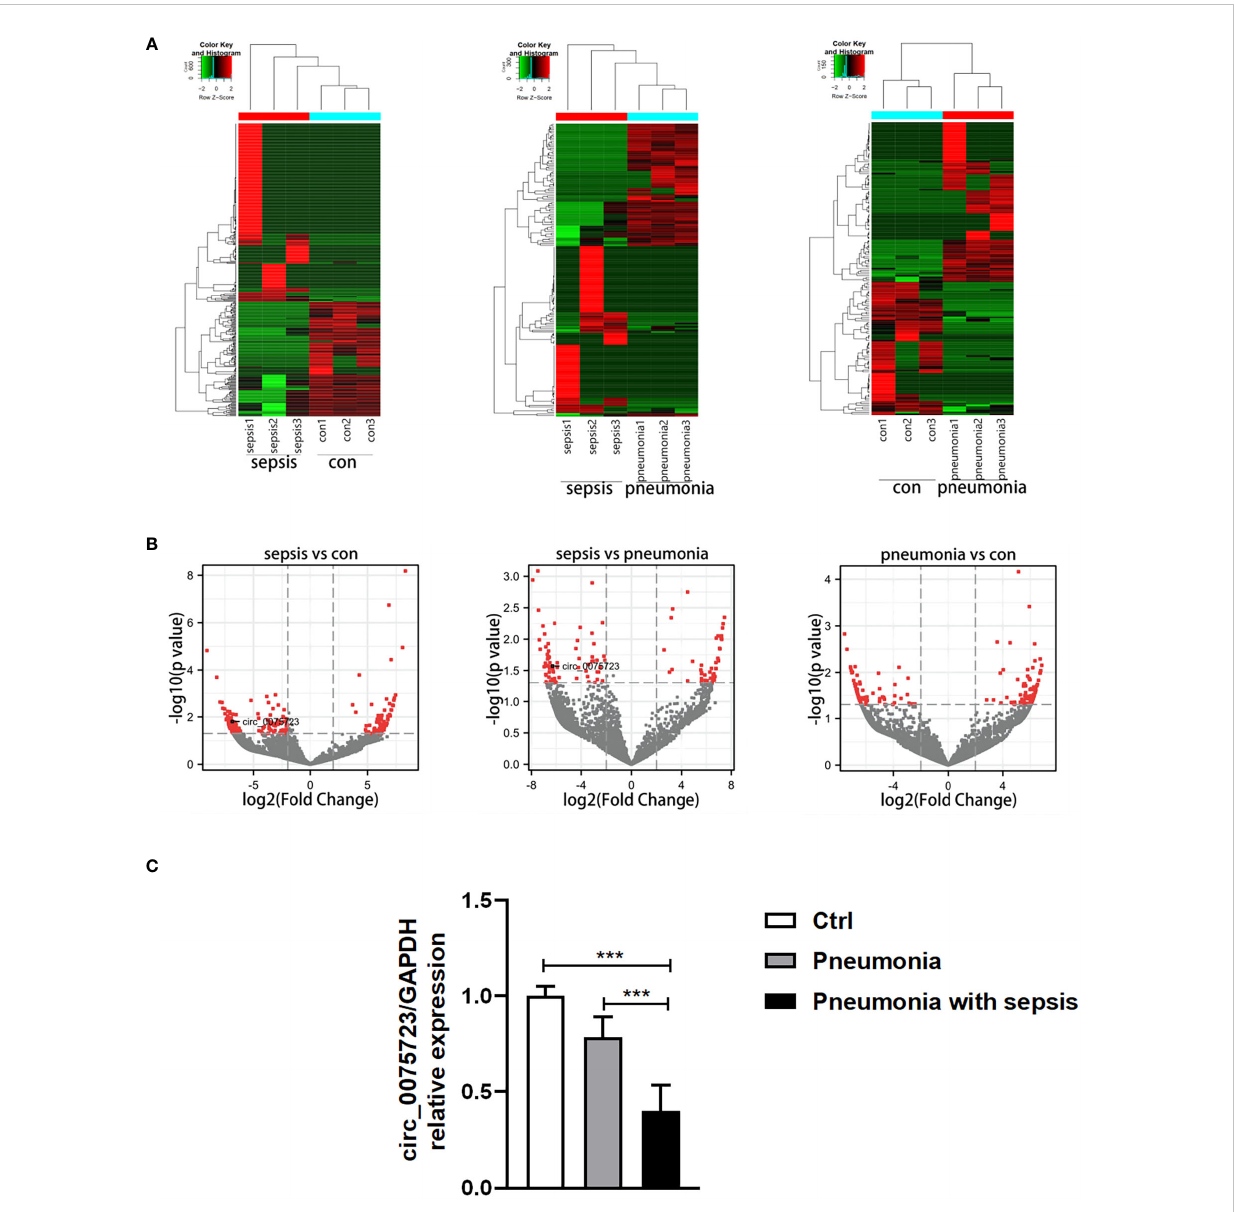
FIGURE 1 Speci fi cal expression pro fi les of circRNAs in pneumonia-induced sepsis. (A) Hierarchical cluster analysis of differentially expressed circRNAs between the two compared groups of plasma. (B) Volcano plots showing the differentially expressed circRNAs among the three groups [Plot of circRNA expression log2 ‐ transformed fold ‐ changes (x ‐ axis) vs ‐ log10 P ‐ value (y ‐ axis)]. The red dots represent the circRNAs having fold change > 2.0 and P < 0.05 between the two compared groups of plasma. (C) qRT-PCR analysis of circ_0075723 expression in CD14+ monocytes among the pneumonia-induced sepsis, pneumonia without sepsis and healthy control group. Each group has 4 samples. Data are presented as means ± SD; signi fi cant difference was identi fi ed with one-way ANOVA. ***p < 0.001 vs. Control or